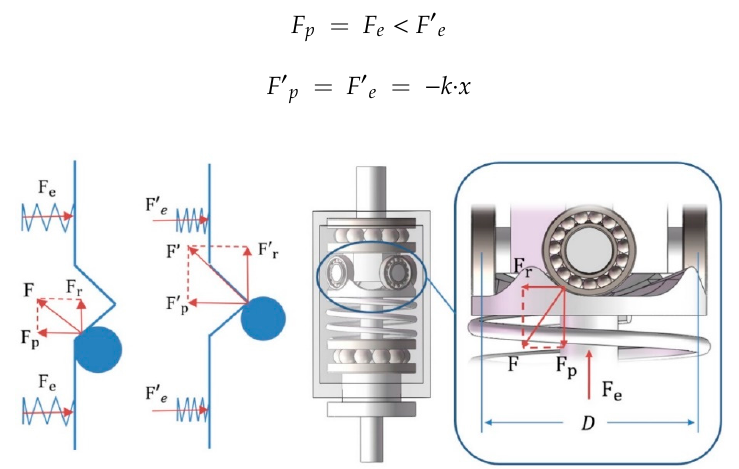
Figure 18. The force analysis of the automatic clutch.